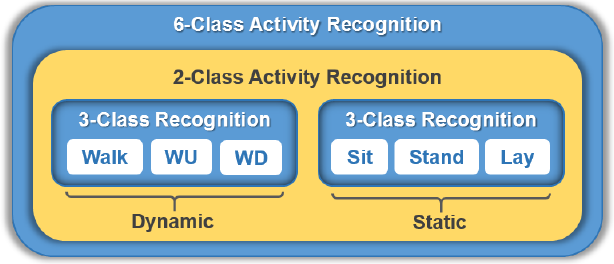
Figure 1. Division of 6-class HAR into two-stage n -class HAR. Six activities, i.e., Walk, WU (Walk Upstairs), WD (Walk Downstairs), Sit, Stand, and Lay, are divided into two groups of abstract activities, Dynamic and Static, to form a 2-class HAR. Each abstract activity forms a 3-class